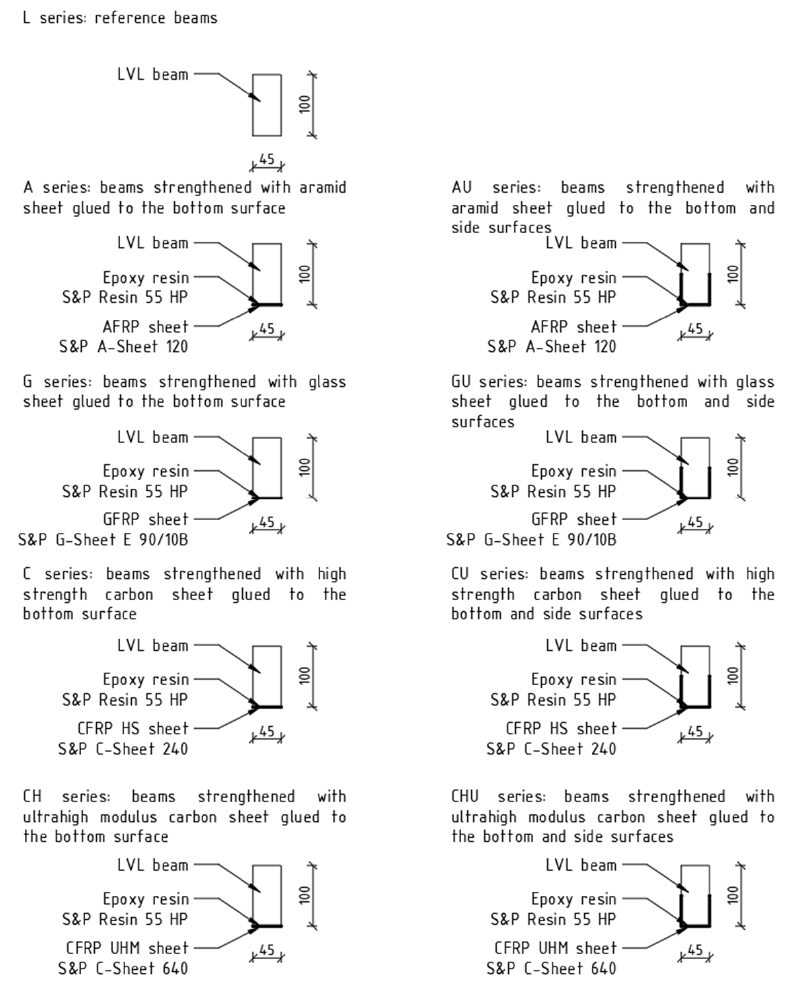
Figure 2. Strengthening schemes of laminated veneer lumber beams. Table 1. Mechanical and physical properties of laminated veneer lumber (exposed by manufacturer)